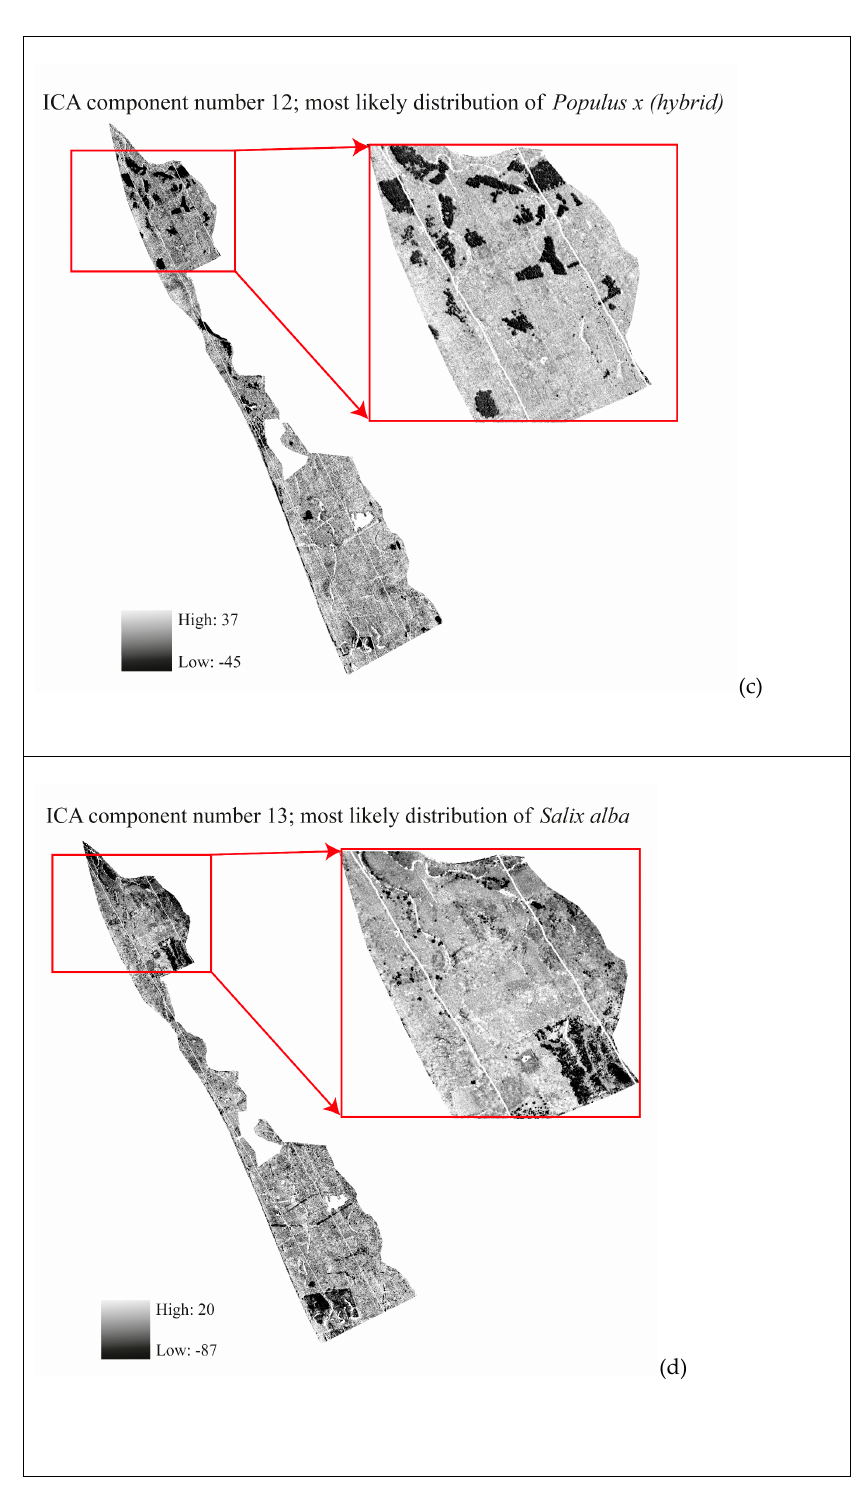
Figure 11. The illustration of independent components after the ICA transformation. In each component, the darker pixels (lower pixel values) have a higher probability of that pixel belonging to a particular feature (or class). For instance, according to expert knowledge, the pixels with lower values in each component most likely comprise the Alnus incana distribution in Figure 11a (ICA component number 7), the Picea abies distribution in the Figure 11b (ICA component number 8), the Populus x (hybrid) distribution in Figure 11c (ICA component number 12) , and the Salix alba distribution in Figure 11d (ICA component number